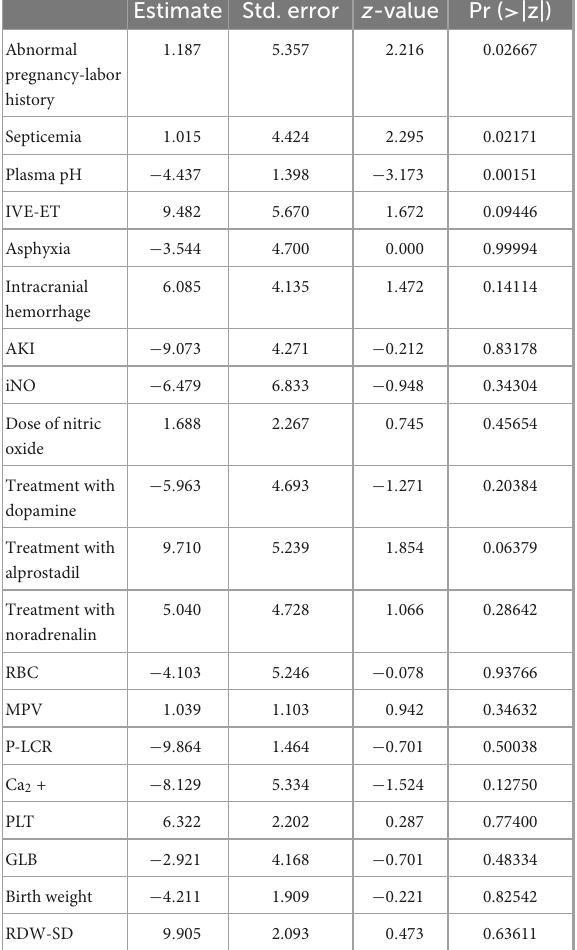
TABLE 2 Multivariable analysis for risk factors for PPHN-associated early death. Estimate Std. error z -value